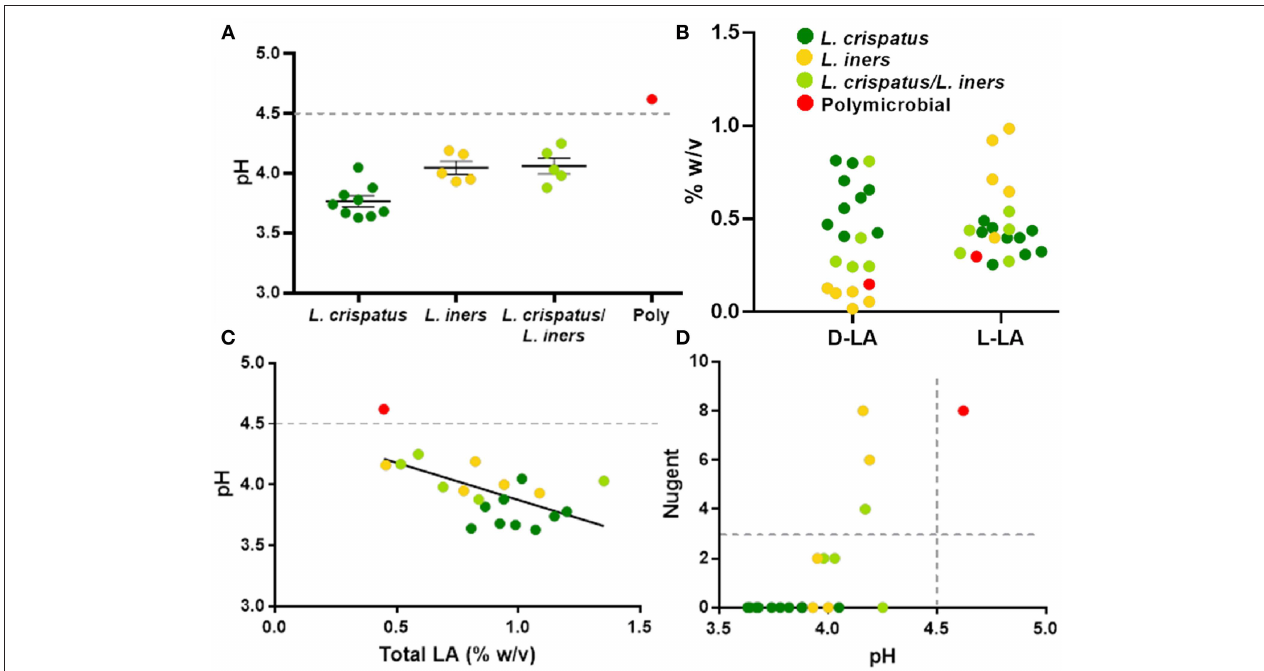
FIGURE 4 | (A) Individual CVS sample pH grouped based on 16S rDNA sequencing. The group mean ± SEM is shown. The gray dotted line corresponds to pH 4.5, which is the clinical cutoff for BV according to Amsel’s criteria. (B) Concentrations of D- and L-isomers of lactic acid (LA) in CVS. Individual data points are color coded for each group based on sequencing. (C) CVS pH as a function of total (D + L) LA content. The gray dotted line corresponds to pH 4.5, which is the clinical cutoff for BV according to Amsel’s criteria. Individual data points are color coded for each group based on sequencing. Linear regression line shown, r 2 = 0.37, p = 0.004. (D) Nugent score as a function of pH. Individual data points are color coded for each group based on sequencing. The gray dotted lines correspond to the threshold for Nugent score considered negative for BV ( ≤ 3) and the clinical cutoff for BV according to Amsel’s criteria (pH